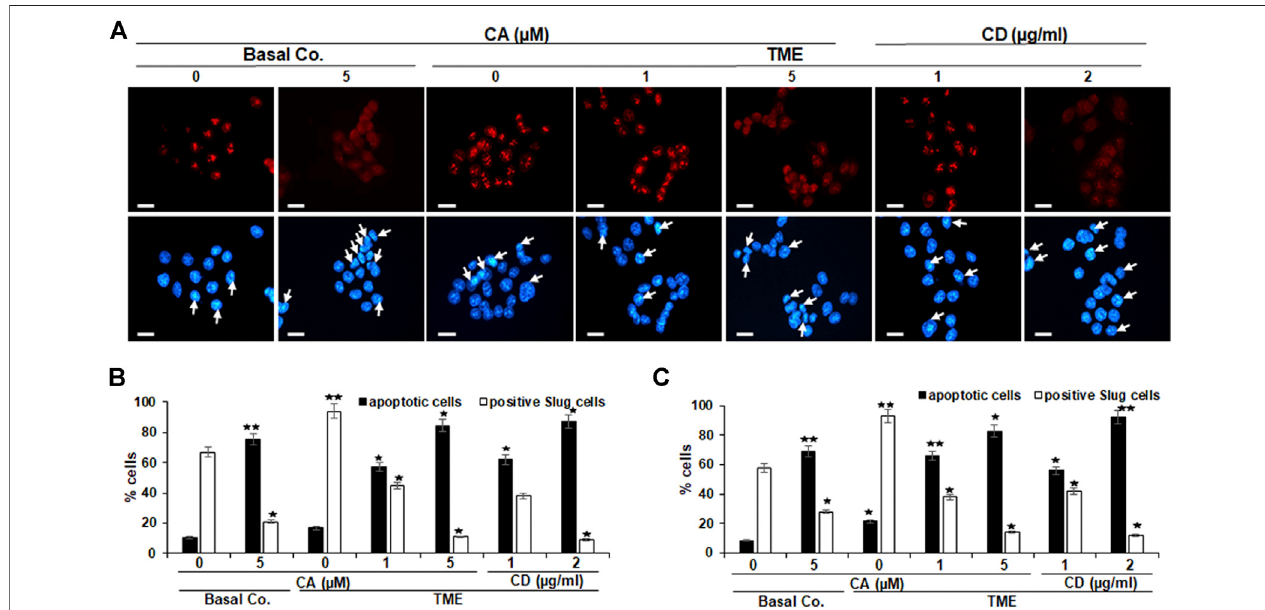
FIGURE3| Calebin AorcytochalasinDactiononEMT-relatedtranscriptionfactor(Slug)expression incolorectalcancercells.HCT116 (A – B) andRKO (C) cellsby themselves(basal co.) subjected toCalebinA(CA) (5 µM), orin TMEwerekept alone untreated,subjected tograded doses ofCalebinA(CA) (1,5 μ M) orcytochalasin